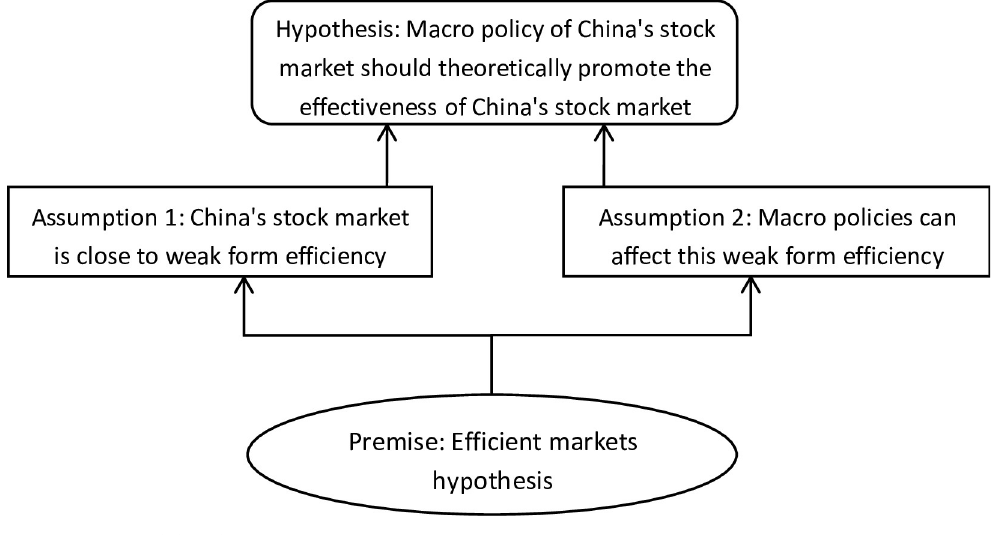
Fig 1. Concept and thought